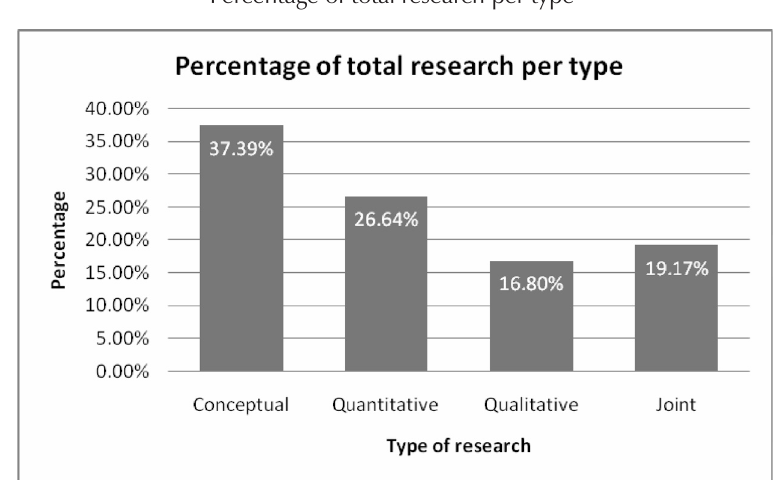
Percentage of total research per